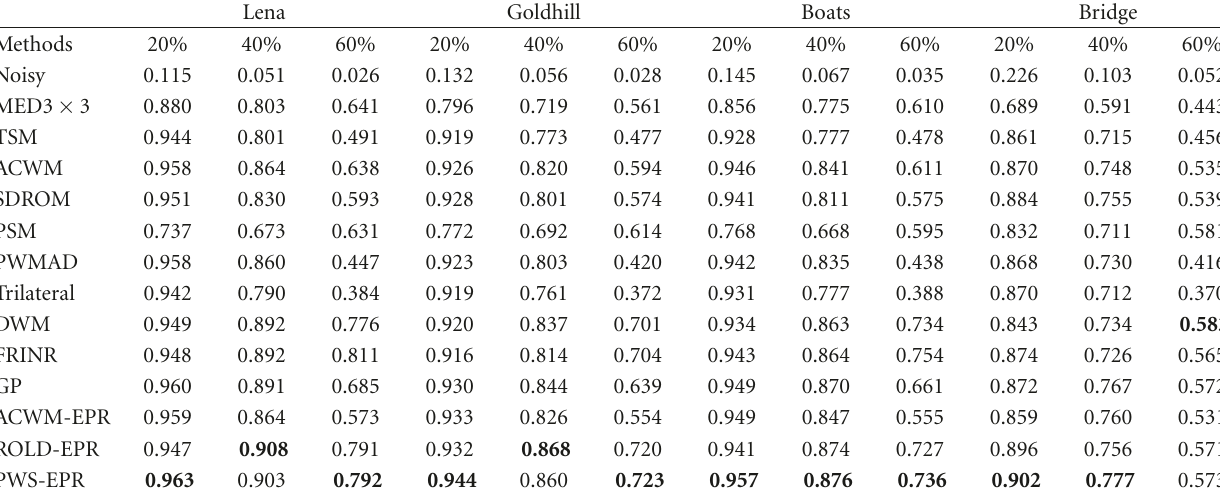
Table 2: Filtering results in MSSIM for images corrupted with mixed impulse noise. Lena Goldhill Boats